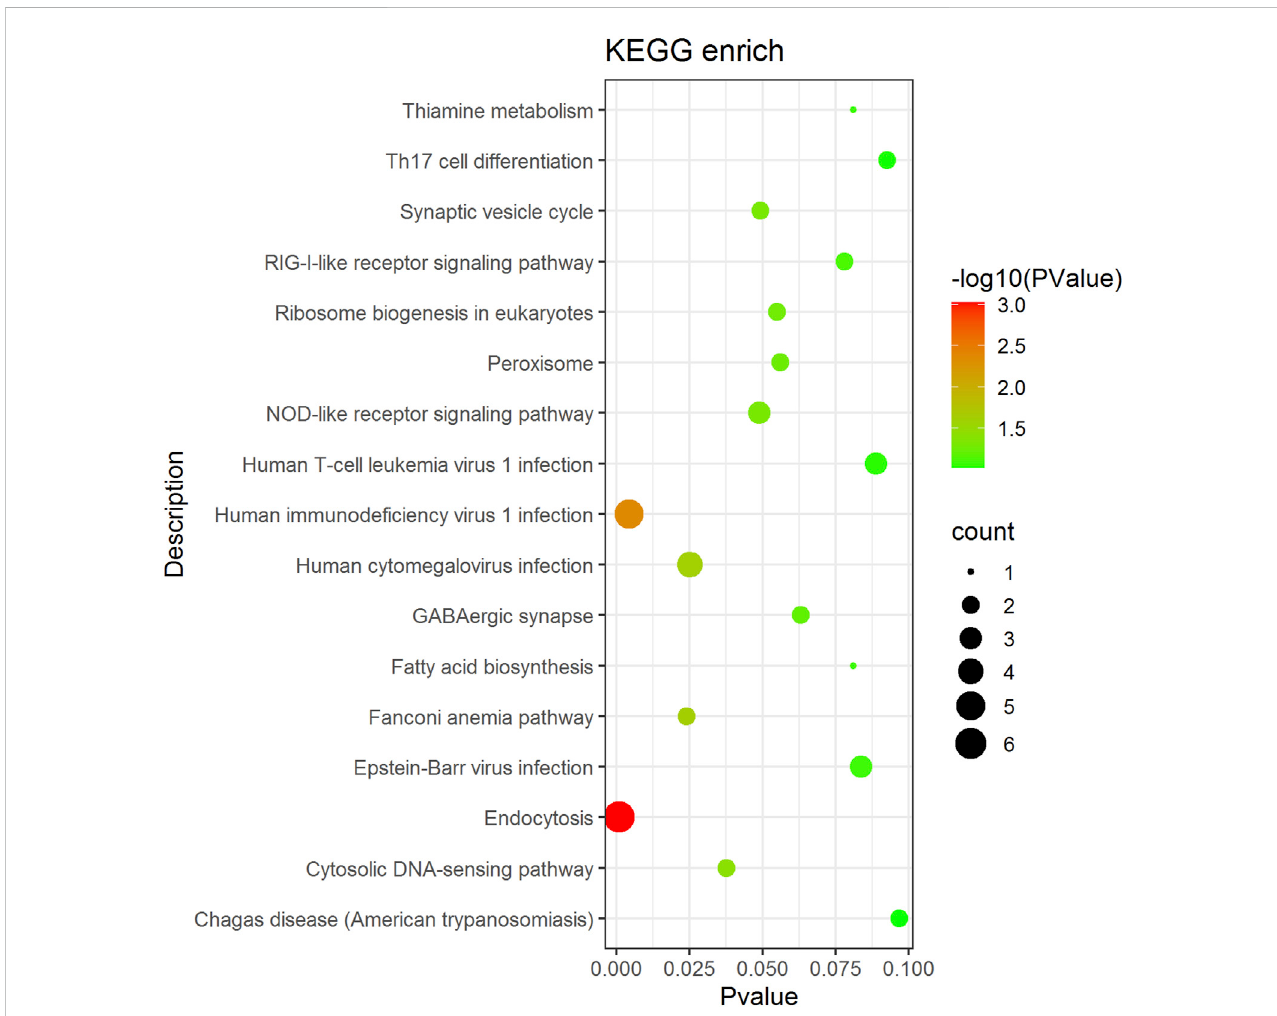
FIGURE 4 Main pathway enrichment of AS genes. The dot size represents the number of genes in the pathway, the color represents the pathway signi fi cance and the vertical coordinate represents the KEGG pathway.